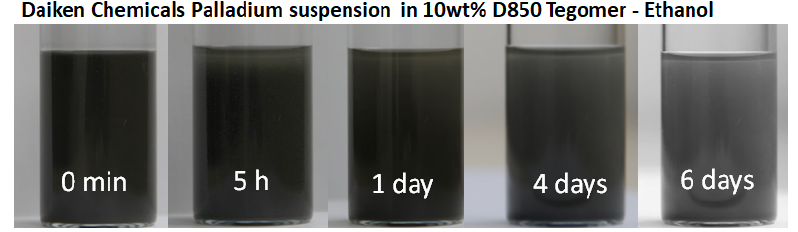
Figure 3. Photos taken of the suspension consisting of 5 wt.% of Daiken Chemicals palladium powder in 10 wt.% Tegomer in ethanol solution for different relaxing times.